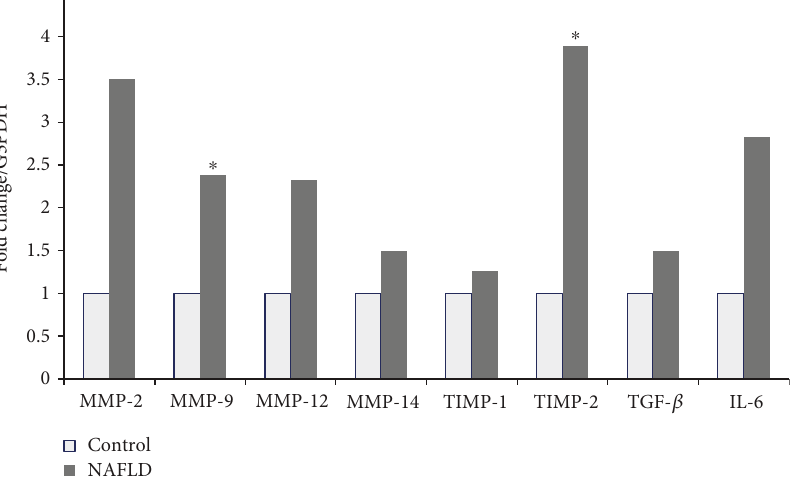
Figure 1: Gene expression in children with NAFLD. Transcript levels of MMP - 9 , TIMP - 1 , MMP - 2 , TIMP - 2 , MMP - 12 , MMP - 14 , TGF - β , and IL - 6 in leukocytes from the control group (open bars) and children with NAFLD (solid bars). Data are expressed as fold changes from children with NAFLD versus the control ( n = 35/37 ). ∗ Statistically signi fi cant at < 0.01 by the Mann-Whitney U